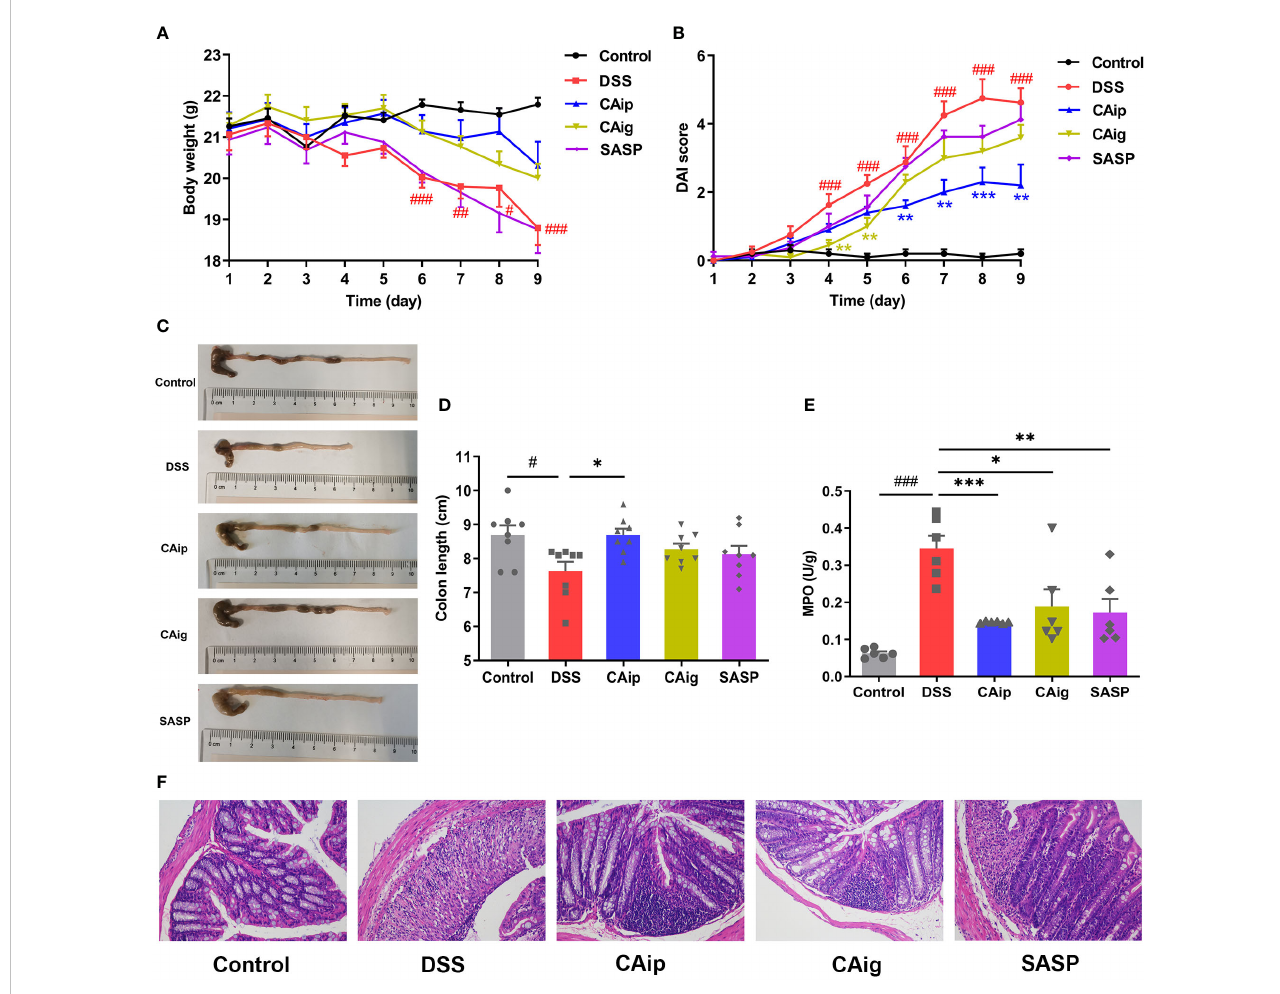
FIGURE 2 CA treatment ameliorated DSS-induced experimental colitis. (A) Body weight change. (B) Disease activity index (DAI) score. (C) Representative pictures of colon appearance and colon length. (D) colon length. (E) MPO activity. (F) Representative microscopic pictures of H&E staining (200 × magni fi cation). (A, B, D) Data are presented as the mean ± SEM (n = 8~10). (E) Data are presented as the mean ± SEM (n = 6). # P < 0.05, ## P < 0.01, ### P < 0.001 vs. Control group, * P < 0.05, ** P < 0.01, *** P < 0.001 vs. DSS